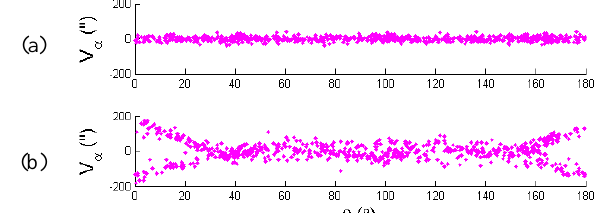
Figure 4: (a) Vertical angle residuals versus horizontal angle plot in point-based self-calibration for panoramic scanners without systematic errors. (b) Unmodelled 3’ vertical circle index error.